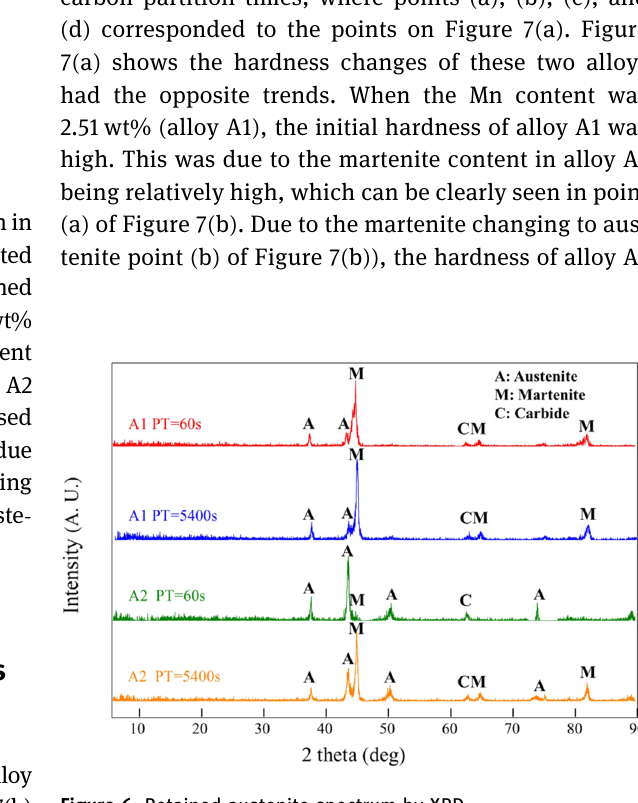
Figure 6: Retained austenite spectrum by